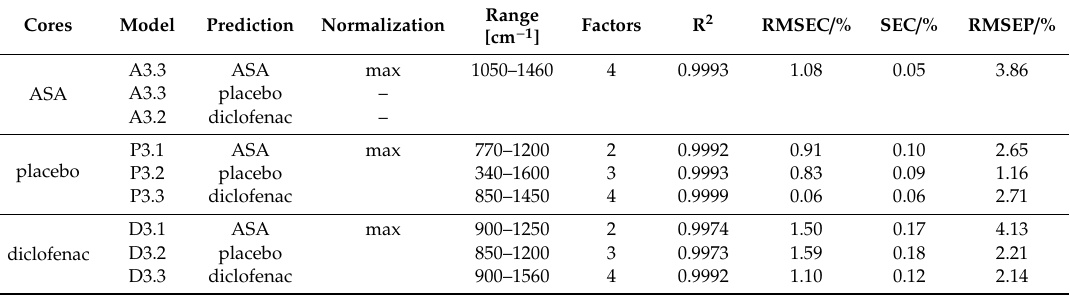
Table 5. PLSR calibration and prediction model performance parameters for inline predictions of the TiO 2 -free coating.